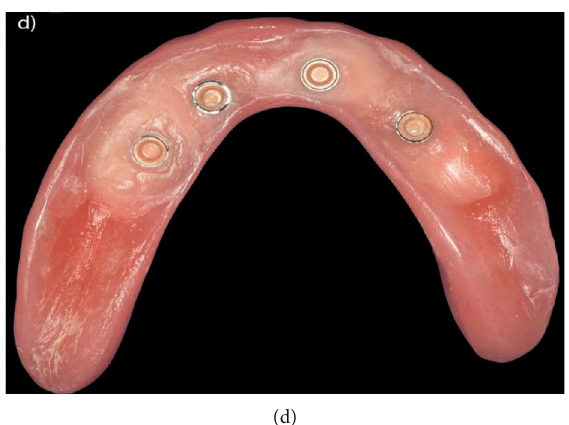
Figure 5: Clinical occlusal loading sequence: (a) occlusal view of Equator attachments connected to implants 2 and 4 and healing caps connected to implants 1 and 3; (b) base of the prosthesis after capturing the O-rings of implants 2 and 4; (c) occlusal view after installation of the Equator attachments connected to implants 1 and 3; (d) prosthesis base after